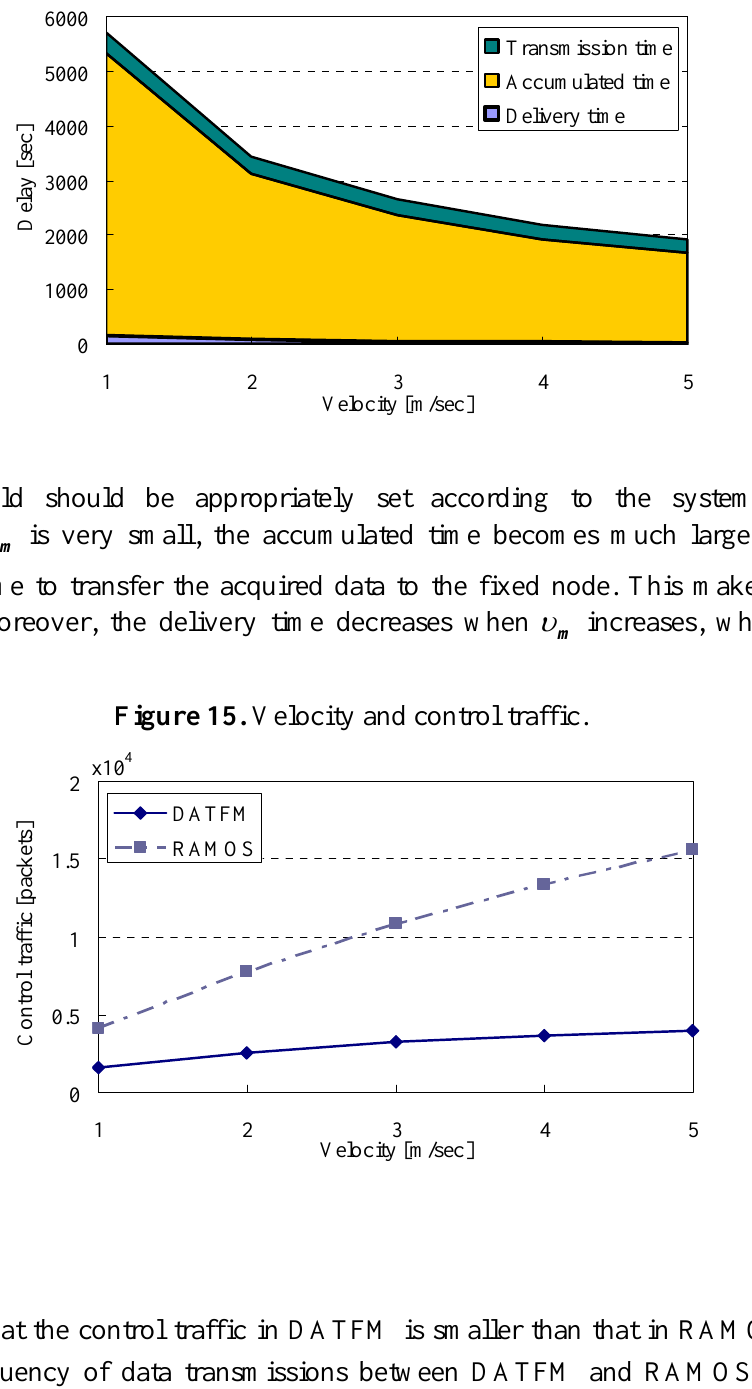
Figure 14. Velocity and details of delay in DATFM.